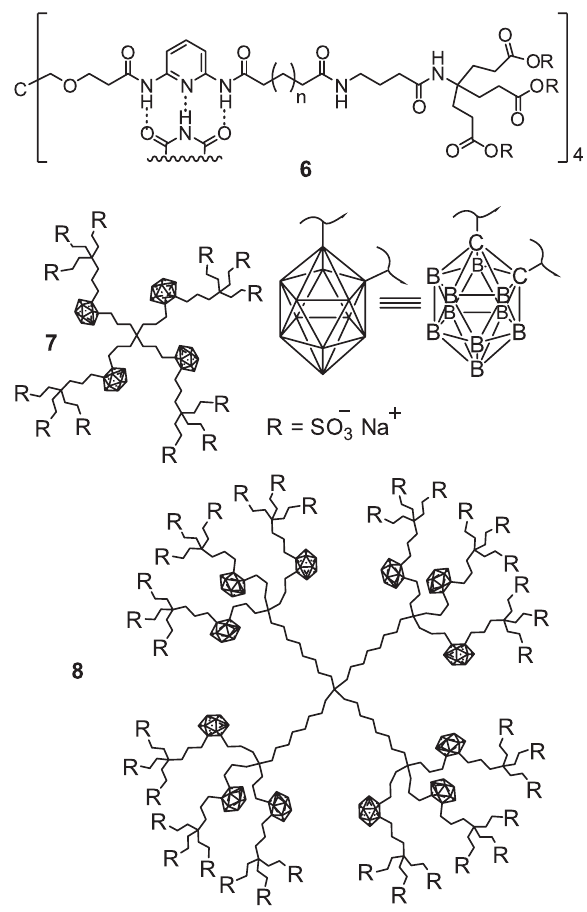
FIGURE 5 – Modification of the dendritic framework can easily facilitate drug delivery and cancer therapies [Newkome, G. R.; Moorefield, C. N.; Keith, J. M.; Baker, G. R.; Escamilla, G. H. Angew. Chem. Int. Ed. Engl. , v.33, p.666-668, 1994 – Redrawn with permission of